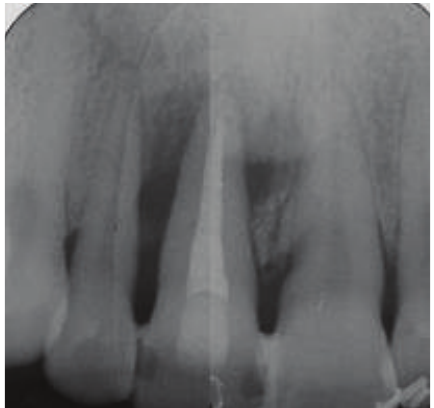
Figure 2: Intraoral periapical radiograph showing bone loss around the right central incisor and involving the mesial alveolar wall of the right lateral incisor.